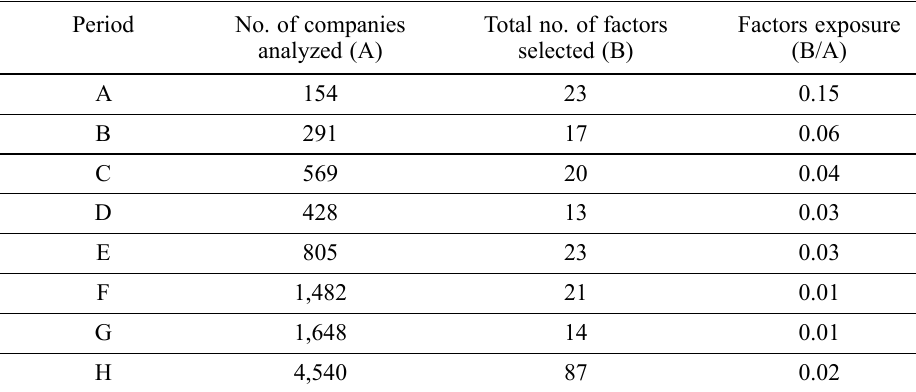
Table 6. Exposure of the periods to